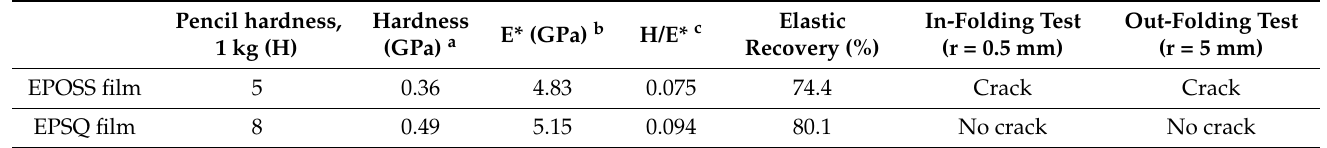
Table 2. Summary of mechanical properties of EPOSS and EPSQ